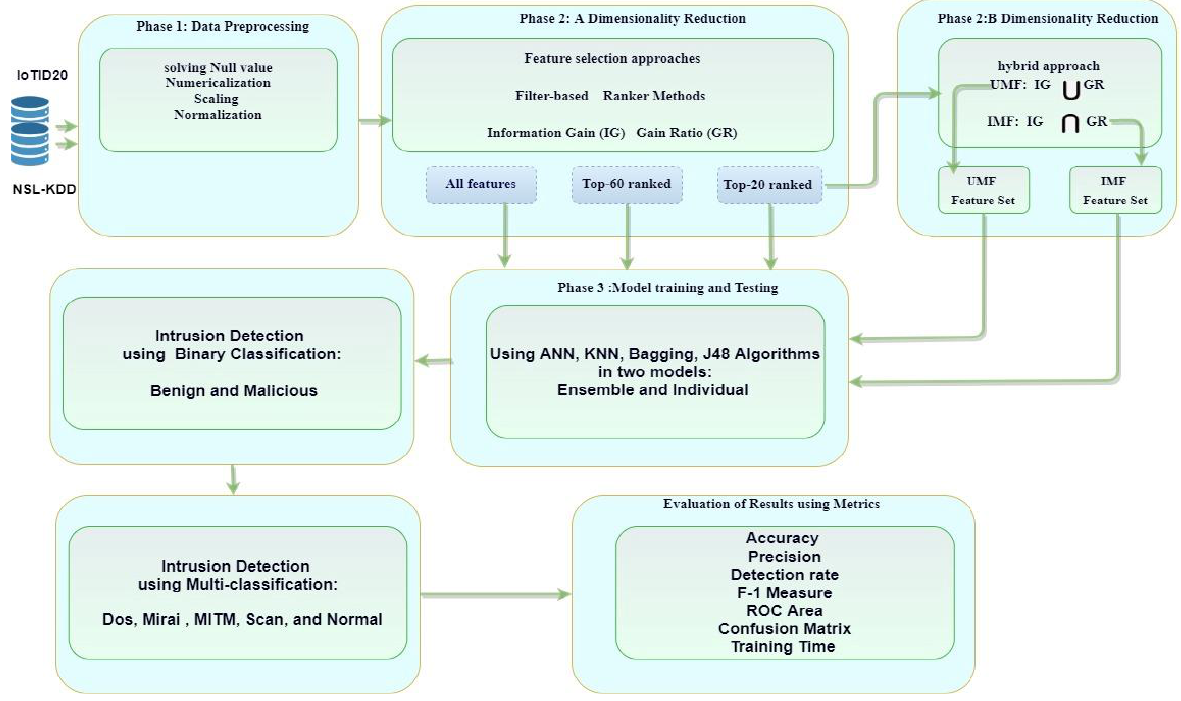
Figure 1. The proposed approach for machine learning-based intrusion detection using hybrid feature selection approach.